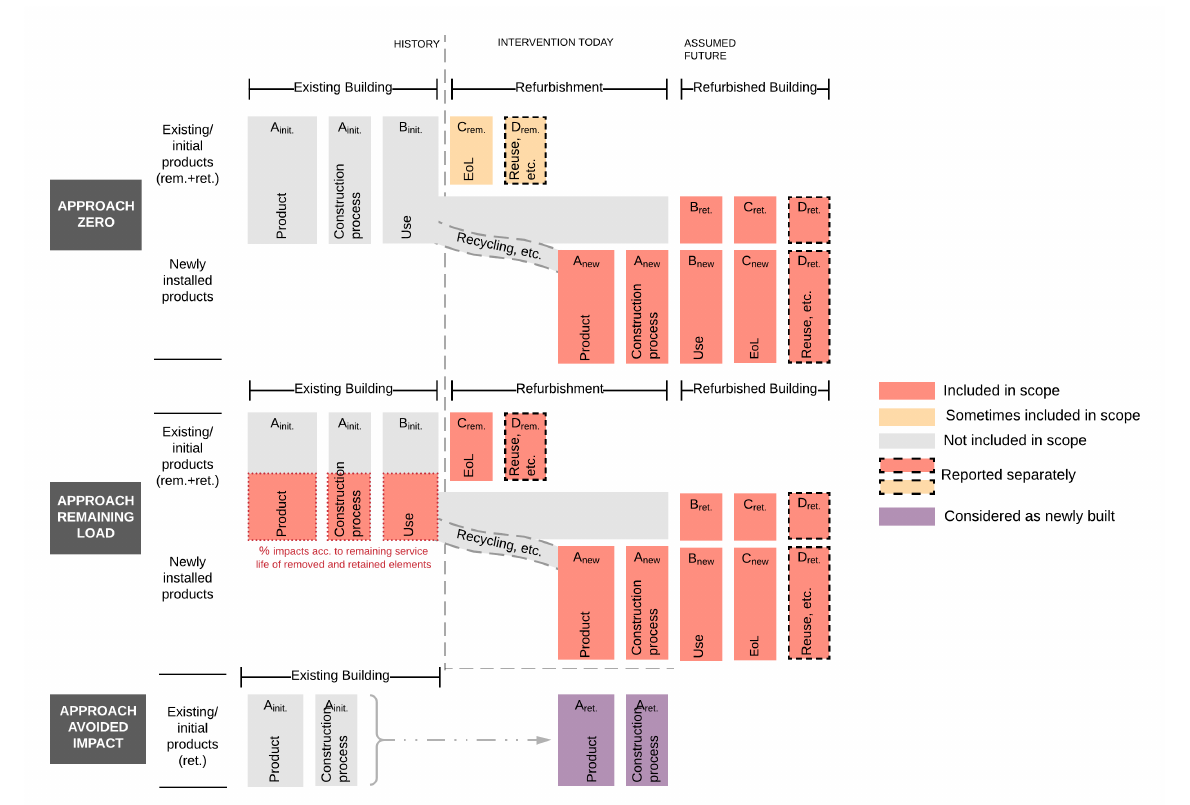
Figure 2. Visualisation of the three modelling approaches. Note: newly added is denoted as “new”, removed is denoted as “rem.” and retained as “ret.”.